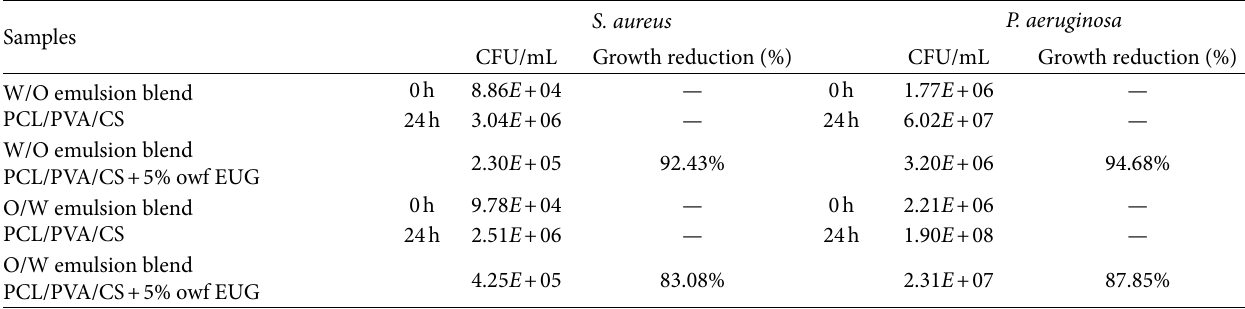
Table 2: Antibacterial efficiency of EUG loaded into electrospun PCL/PVA/CS fiber mats against S. aureus and P. aeruginosa , expressed in percentage of bacterial reduction (%R).